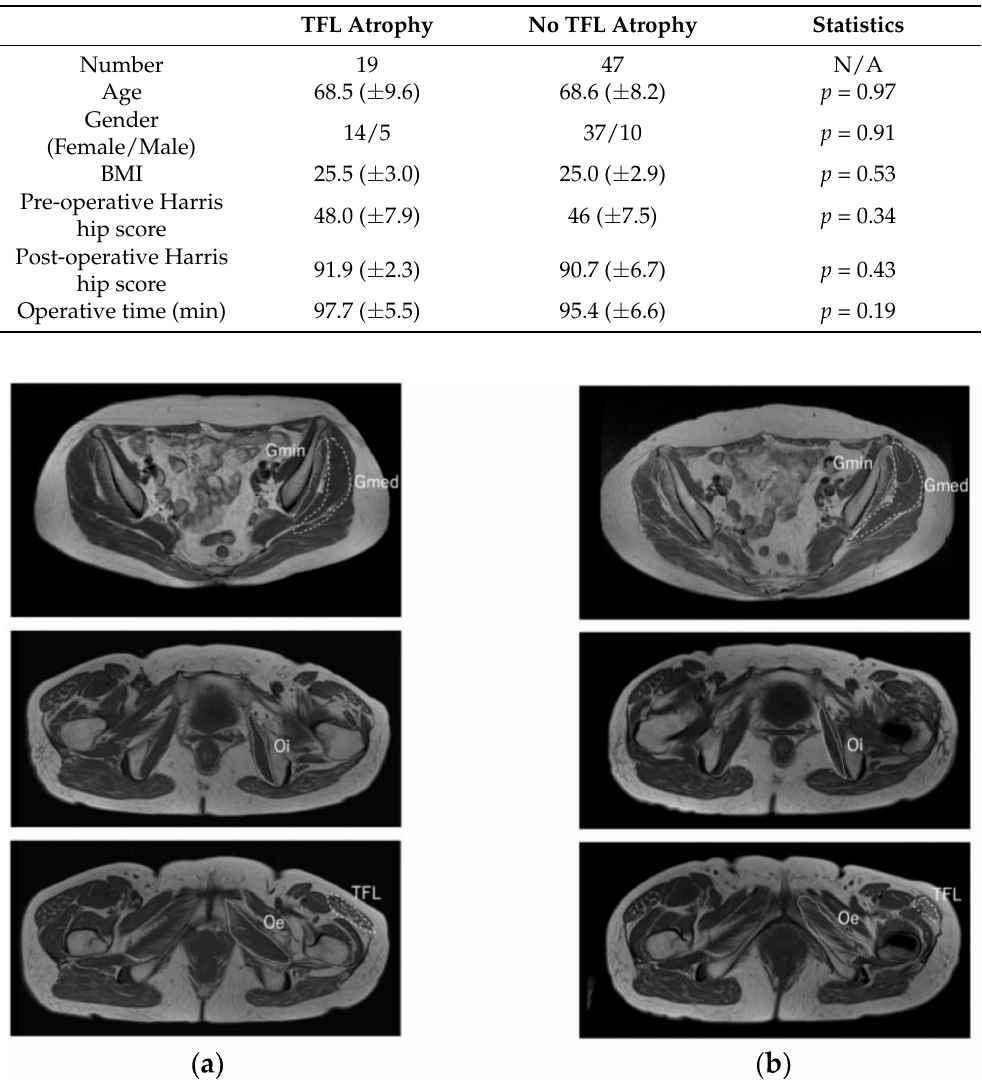
Figure 6. Pre-operative and 12-month post-operative T 1 -weighted magnetic resonance imaging axial scans of the bilateral hip joint. ( a , b ) show pre-operative and 12-month post-operative images, respectively. The left side is the affected side. Muscles surrounding the left hip joint analyzed were the Gmin (solid line), the Gmed (dashed line), the Oi (solid line), the Oe (dotted line), and the tensor fascia latae (TFL) (dashed line). Post-operative TFL shows decreased muscle cross-sectional area and worsened fatty atrophy.